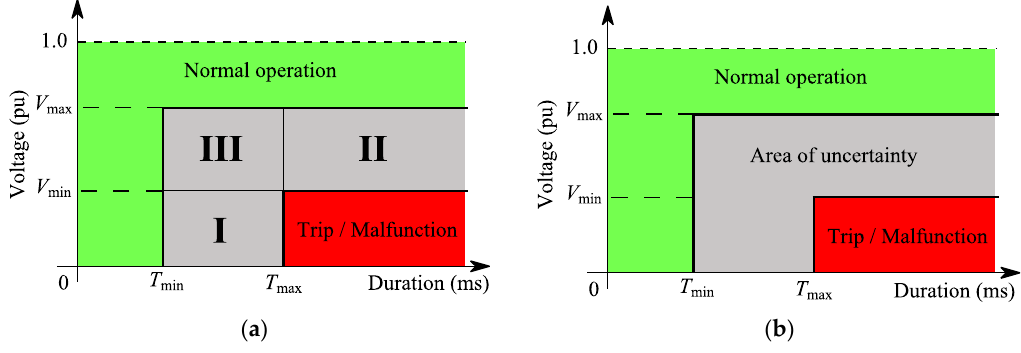
Figure 2. Area of uncertainty: ( a ) defined by voltage–tolerance characteristics; and ( b ) divided into sub-regions.